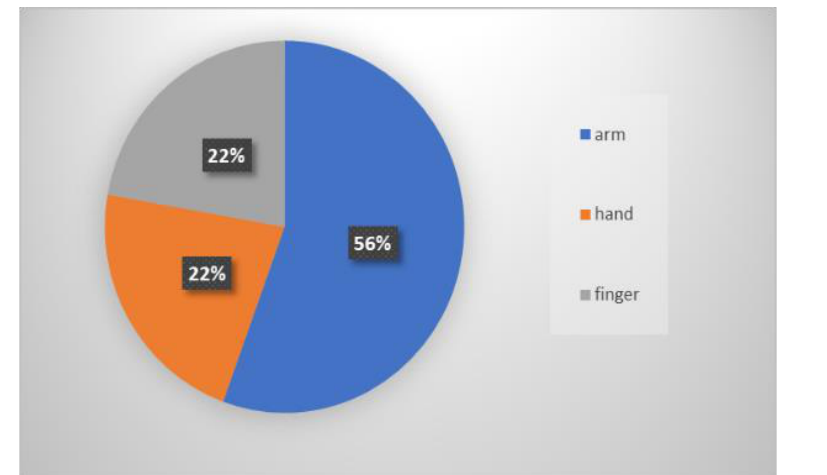
Figure 6 – EEG signal control in the exoskeleton research studiesfrom Table 3 Рис. 6 – Управление сигналом ЭЭГ в исследованиях экзоскелета из Таблицы 3 Слика 6 – Управљање ЕЕГ сигналом у истраживачким студијама које се баве